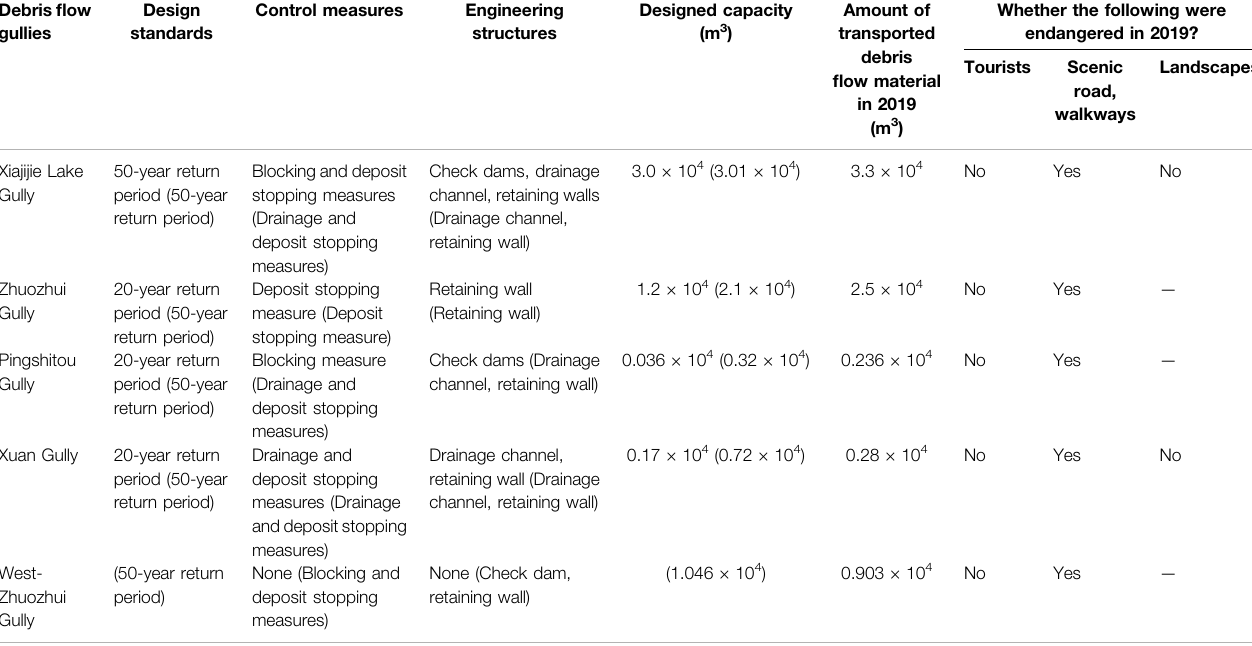
TABLE 1 | Mitigation effectiveness of the debris fl ow control projects completed in May 2019. Debris fl ow